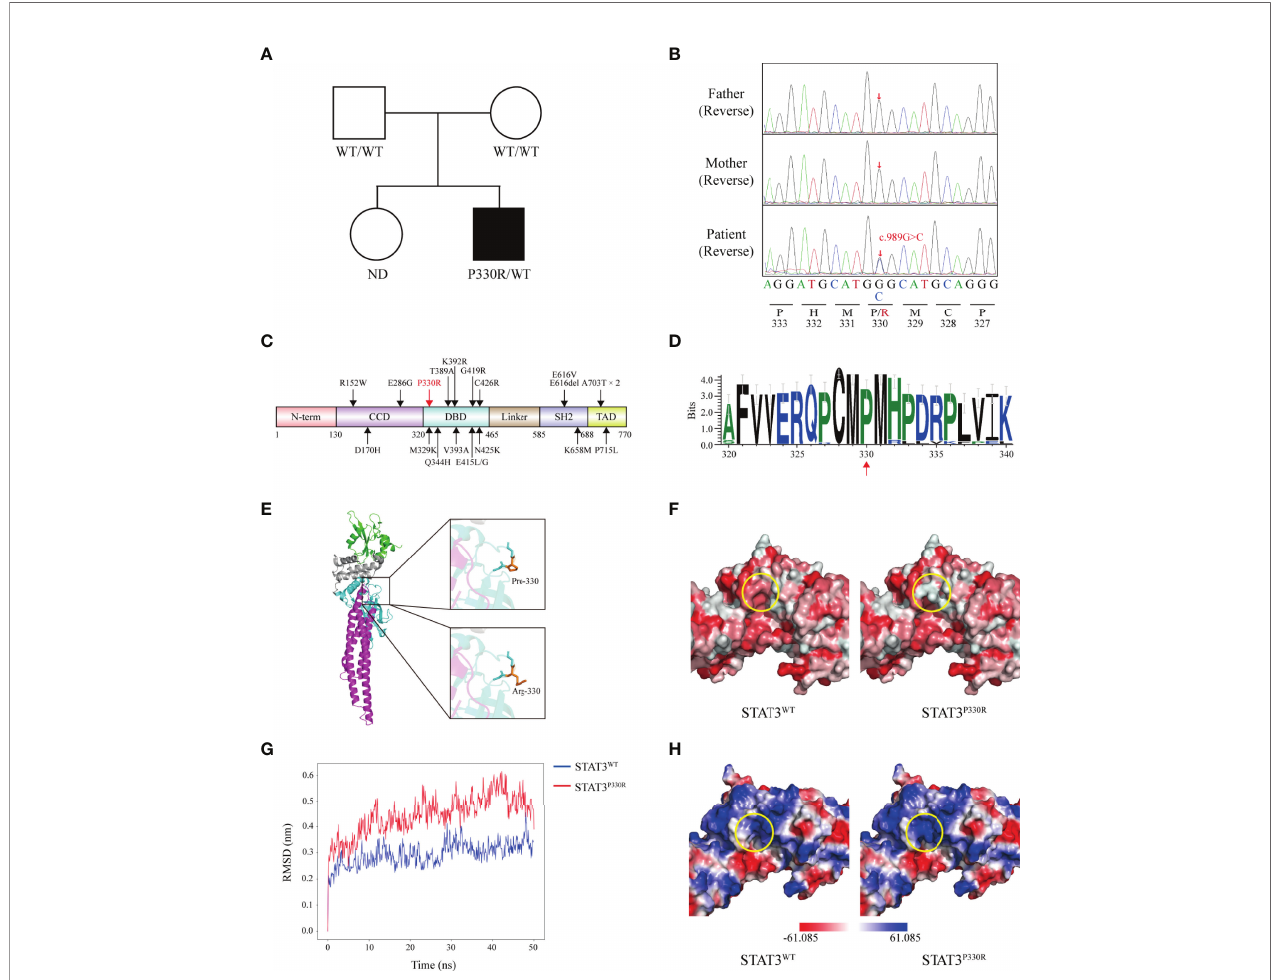
FIGURE 2 | A novel de novo heterozygous mutation is identi fi ed in STAT3. (A) Pedigree of the affected family. Circles, females; squares, males; fi lled symbol, affected subject; open symbols, unaffected family members. ND, not determined. (B) Sequence analysis of the patient and his parents. The heterozygous single base substitution (c.989C>G, p.P330R) in STAT3 is shown. (C) The schematic diagram shows the location of ILD-related GOF mutations on the STAT3 protein reported before. The position of the novel mutation identi fi ed in this study is marked in red. N-terminal domain (N-term), coiled-coil domain (CCD), DNA-binding domain (DBD), Linker domain (Linker), SH2-domain (SH2), and transactivation domain (TAD). (D) WebLogo demonstrates conservation of STAT3 amino acid sequence in 35 vertebrate species. (E) Crystal structure of the STAT3 (left) is shown in cartoon representation and colored as follows: CCD (magenta), DBD (cyan), Linker (grey), and SH2 (green). Magni fi ed pictures displayed the sticks of Met329, Pro330 (top-right), Arg330 (bottom-right), and Met331 residue. Pro330 and Arg330 are colored in orange. (F) The predicted hydrophobicity (circled, yellow) of STAT3 WT and STAT3 P330R . Gradient colors from red to white indicate a hydrophobicity scale from high to low. (G) The root-mean-square deviations (RMSDs) of the STAT3 WT and STAT3 P330R during 50 ns of molecular dynamics simulations. (H) The calculated electrostatic potentials of the STAT3 WT and STAT3 P330R are mapped on the surfaces and colored in a gradient from red (negative) to blue